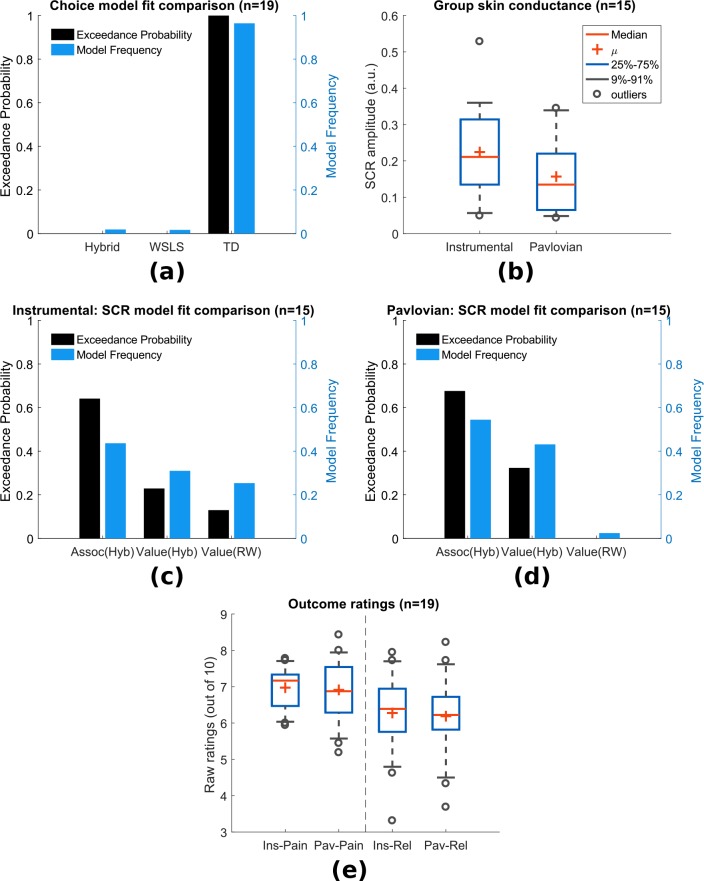
Experiment 1: behavioural results.(a) Choice-fitted model comparison, TD model fit instrumental sessions choices best (TD: action-learning model with fixed learning rate, Hybrid: action-learning model with associability as changing learning rate, WSLS: win-stay-lose-shift model). Model frequency represents how likely a model generate the data given a random participant, while exceedance probability estimates how one model is more likely compared to others (Stephan et al., 2009). (b) Instrumental vs Pavlovian sessions SCRs (n = 15, sessions with over 20% trials <0.02 amplitude excluded). (c) Associability from hybrid model fitted trial-by-trial SCRs best in instrumental sessions (Assoc: associability, Hyb: hybrid model, RW: Rescorla-Wagner model). (d) Associability also fitted SCRs from Pavlovian sessions best. (e) Both pain and relief ratings did not differ significantly between instrumental and Pavlovian sessions (Participants’ ratings were averaged for each of the four categories shown, mean = 8 ratings per person per category).10.7554/eLife.31949.008Figure 2—source data 1.Experiment 1’s behavioural data including SCRs, choices, ratings can be found in zip file attached.